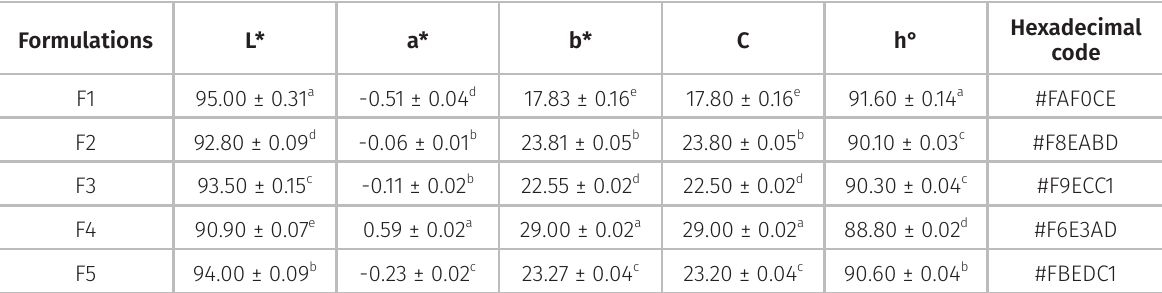
Table III. Mean values for colour parameters obtained for the wild passion fruit ( Passiflora cincinnata Mast.)